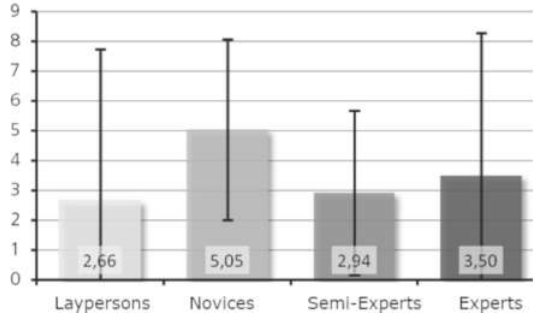
Figure 10. Revisits per minute on basic features (Moses).